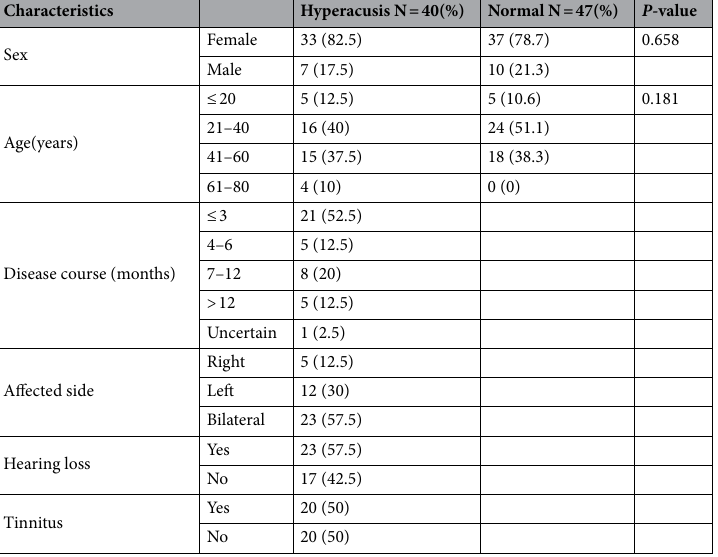
Table 1. Characteristics of subjects.